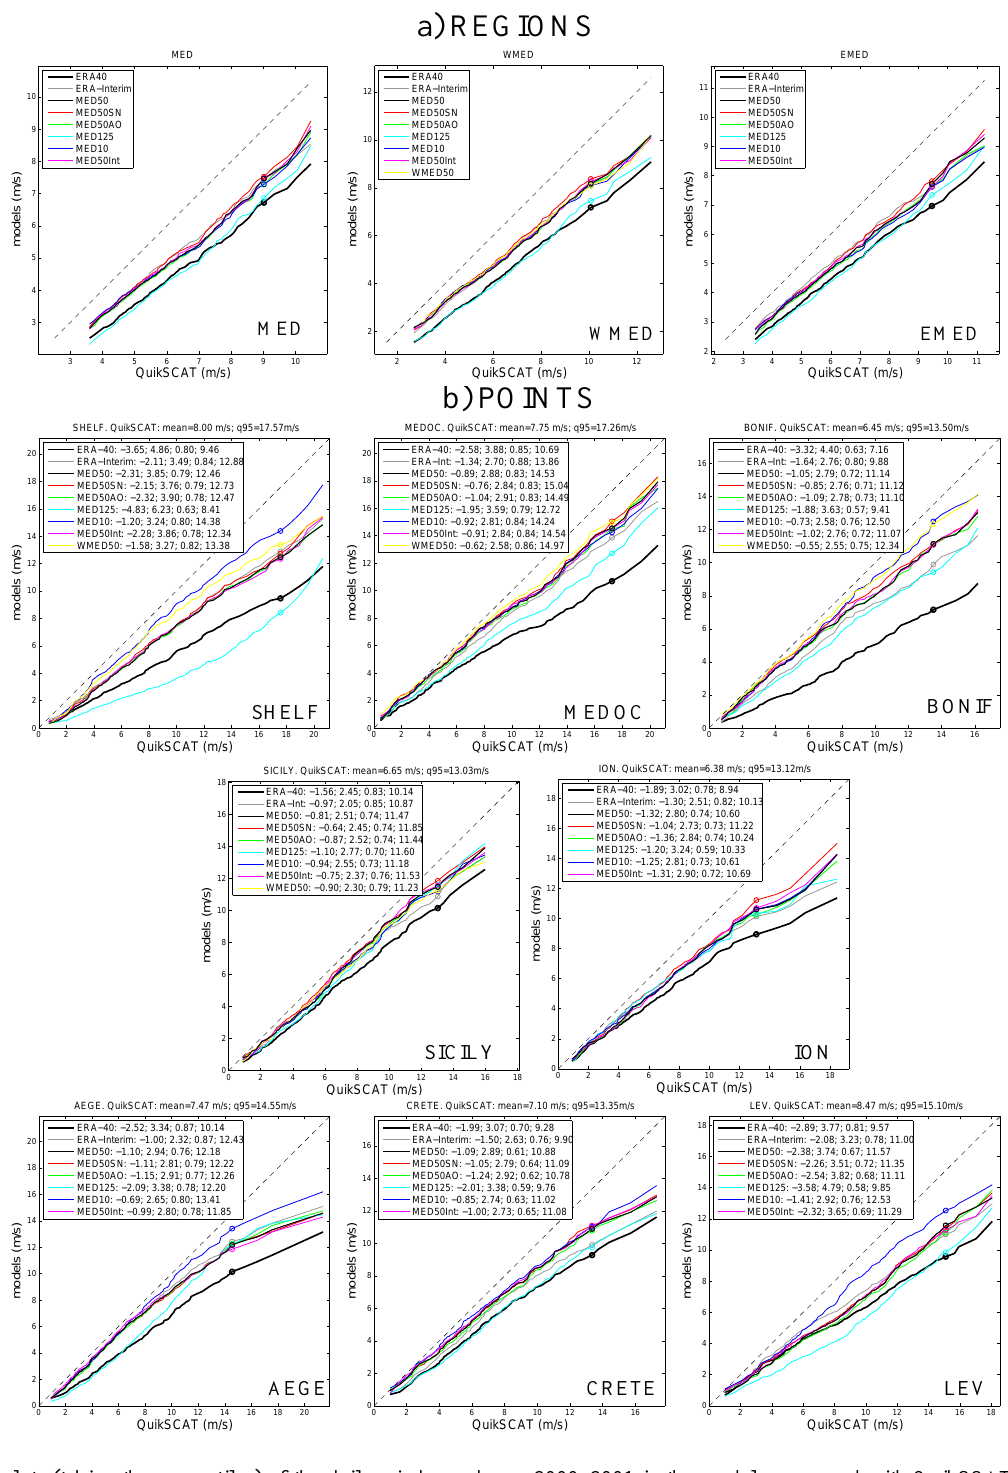
Fig. 5. Q - Q plots (taking the percentiles) of the daily wind speed over 2000–2001 in the models compared with QuikSCAT (a) averaged over the whole Mediterranean Sea (left), the Western Basin (middle) and the eastern Mediterranean (right) and (b) for each point located in a region of strong wind (Fig. 1). The value of the 95th percentile is indicated by a circle. For each point the average value over 2001–2001 and the value of the 95th percentile in QuikSCAT is indicated above each graph for each point. For each model we also indicate in the legend respectively the bias compared to QuikSCAT, the RMSE, the correlation and the value of the 95th percentile. Unit: ms − 1